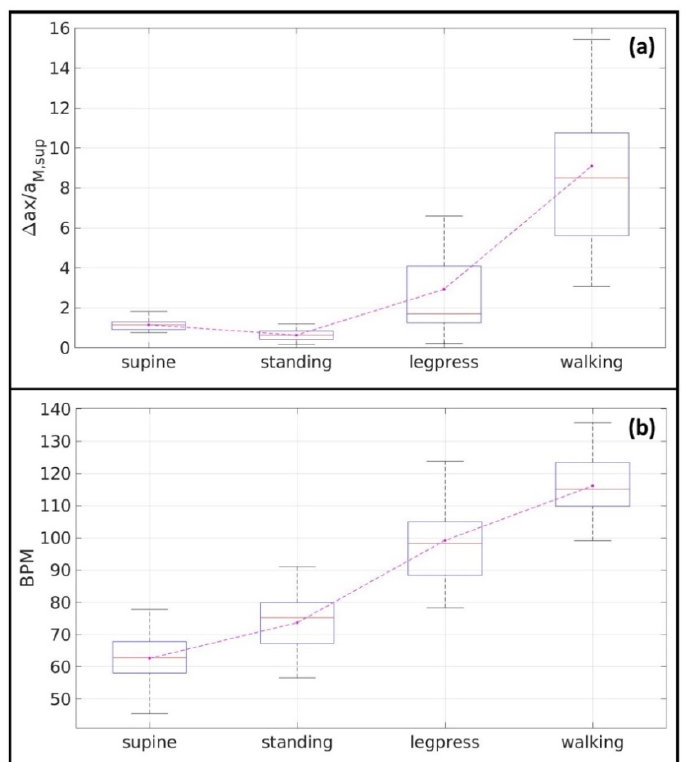
Figure 4. The ∆ ax parameter normalized with respect to the a M,sup value ( a ), and the heartbeat values ( b ).